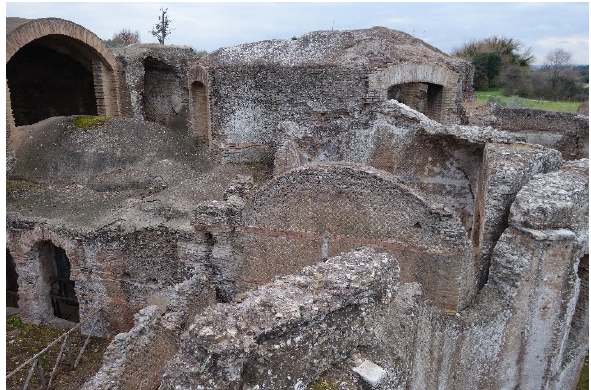
Figure 1. Access Vestibule to the Golden Court: this central Figure 2. Picture showing the complex shape of Small Baths’ plan building is adjacent to the portico that gives the name to roofing made of intersecting the complex.